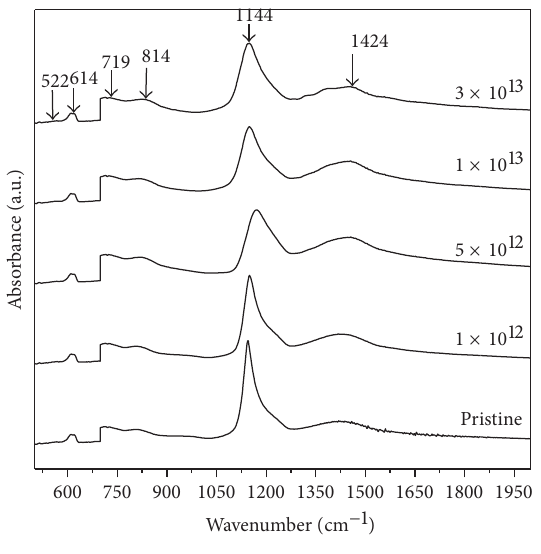
F 11: Showing the FTIR spectra of Ag for BBiSB series.